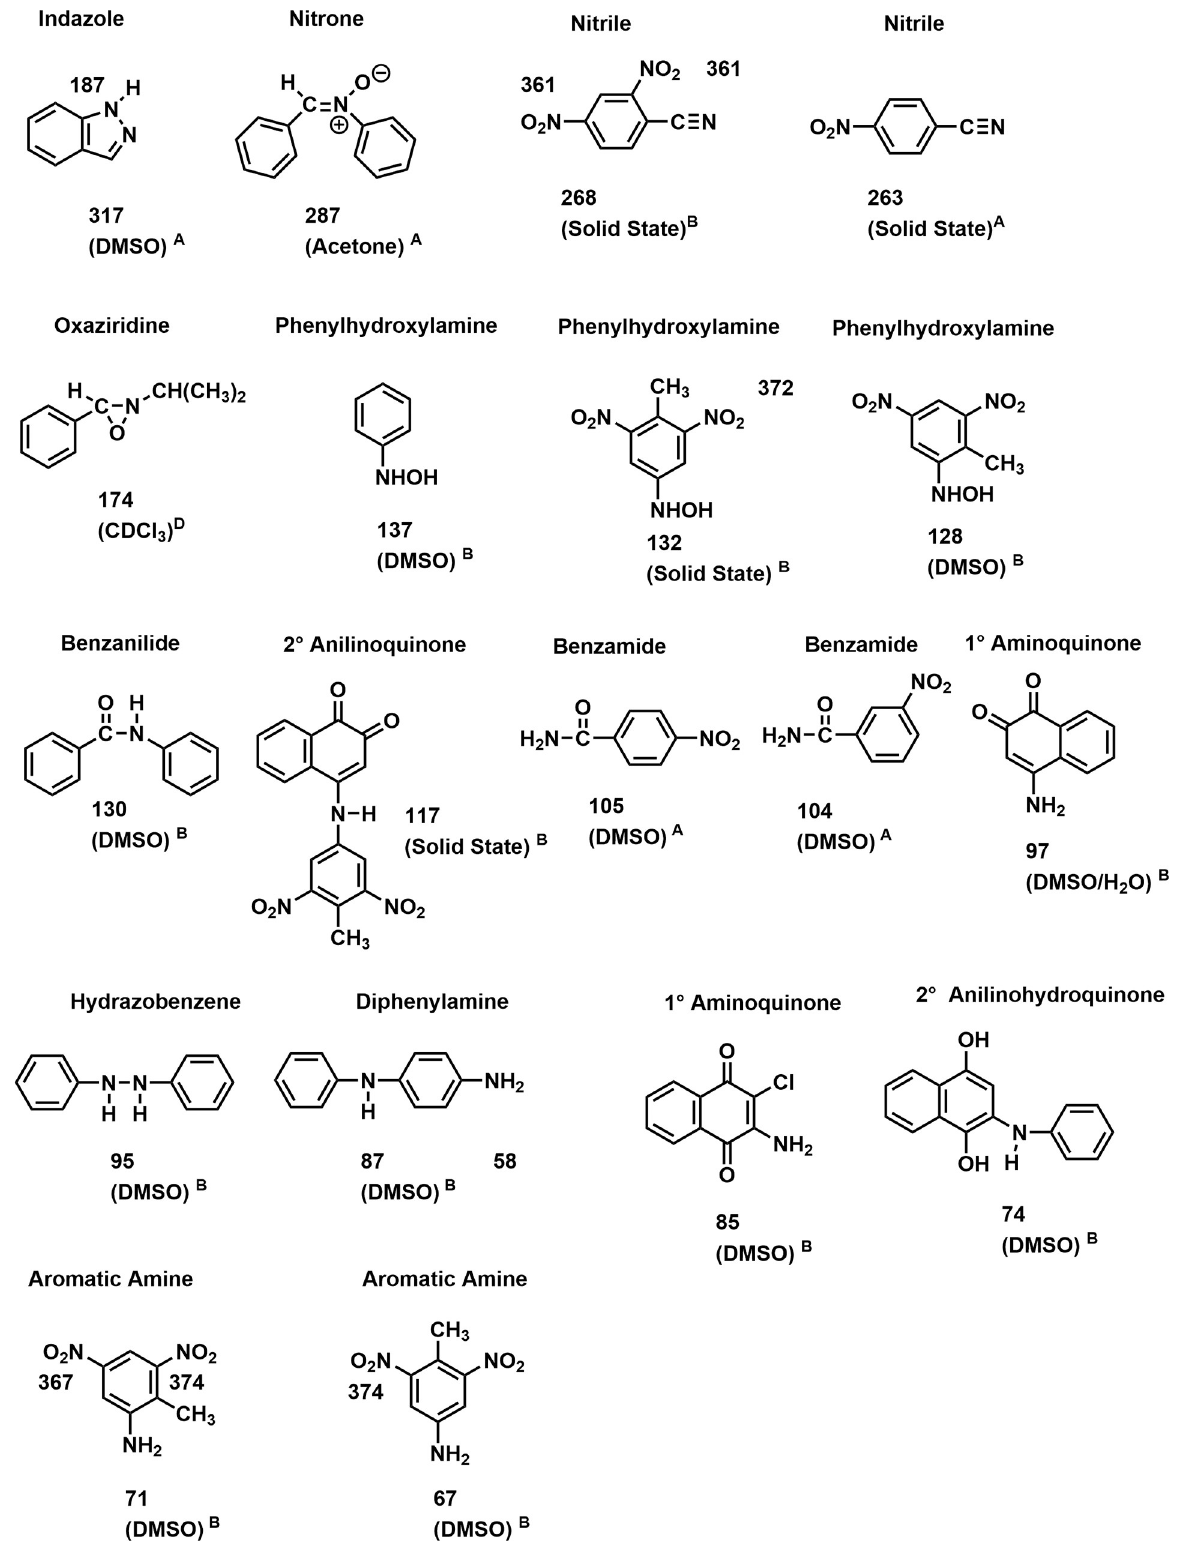
Fig 7. N-15 NMR chemical shifts of nitrogen compounds. A: Ref 73 & 76; B: Determined in this laboratory; C: Ref 75; D: Ref 74.